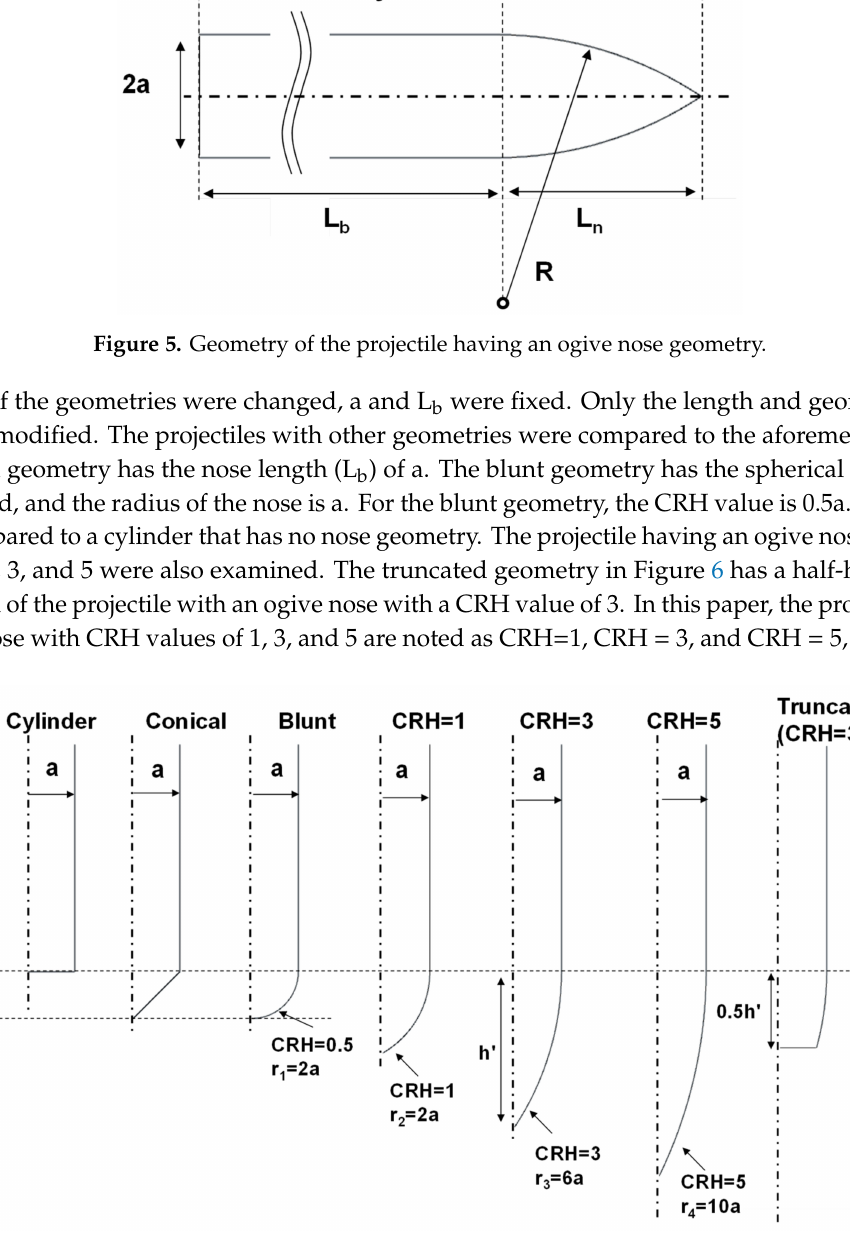
Figure 6. Compared geometries of the